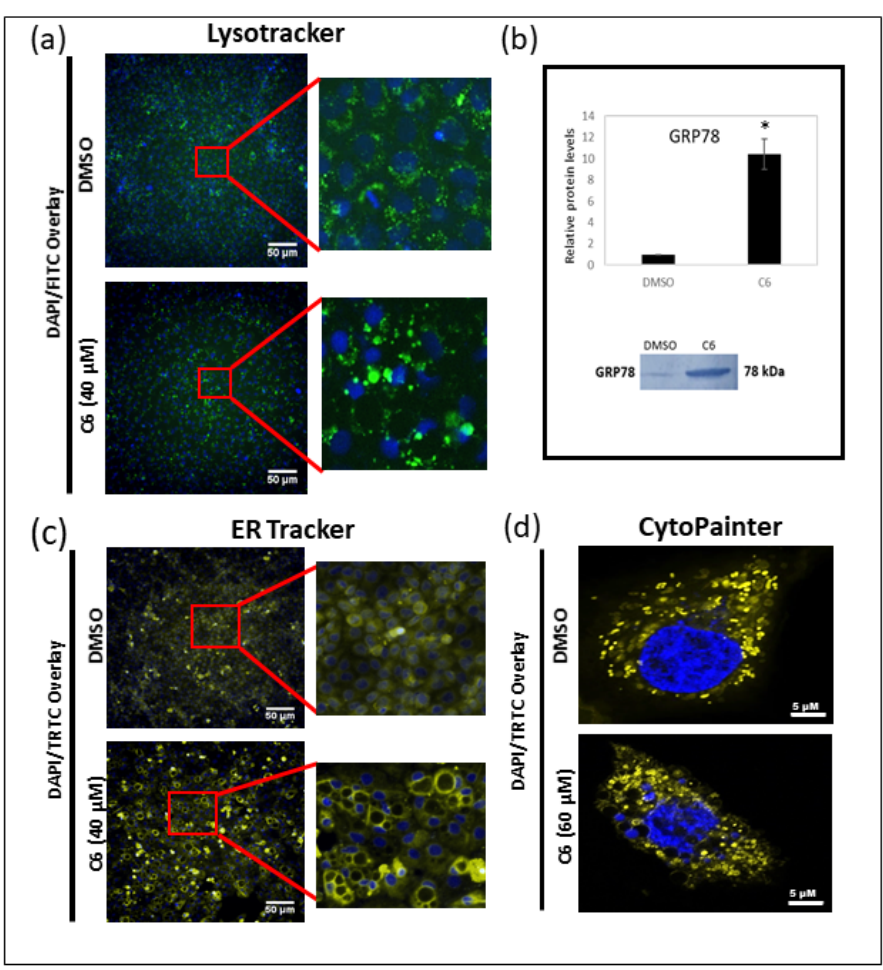
Figure 9. Evaluation of the MCF-7 organelle structures and GRP78 protein expression. ( a ) Representative micrographs of MCF-7 cells stained with Lysotracker TM for lysosomes, ( b ) Western blot analysis representing the relative protein expression levels of GRP78 in MCF-7 cells treated with C6 (40 µM) and representative membrane showing band intensities, * p < 0.05 relative to the DMSO vehicle control. Representative micrographs of MCF-7 vehicle control and C6-treated cells stained with ( c ) ER Tracker TM to visualize the endoplasmic reticulum membrane and ( d ) CytoPainter TM to visualize the mitochondria.